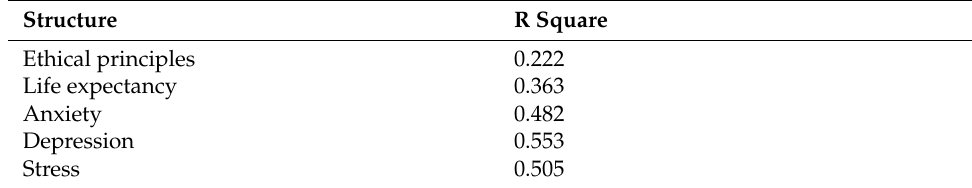
Table 3. The values of R 2